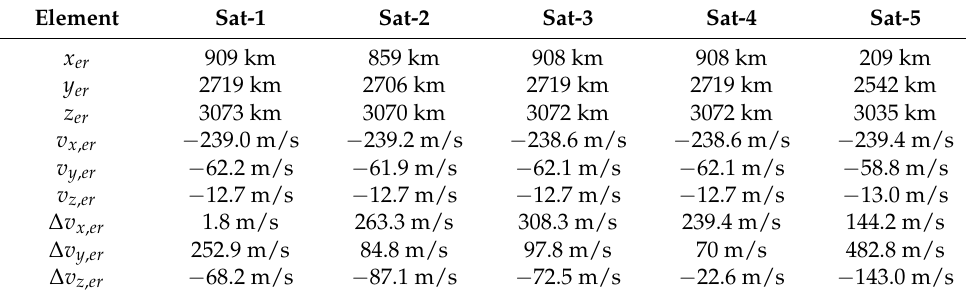
Table 5. State variables in the equilibrium region before and after the